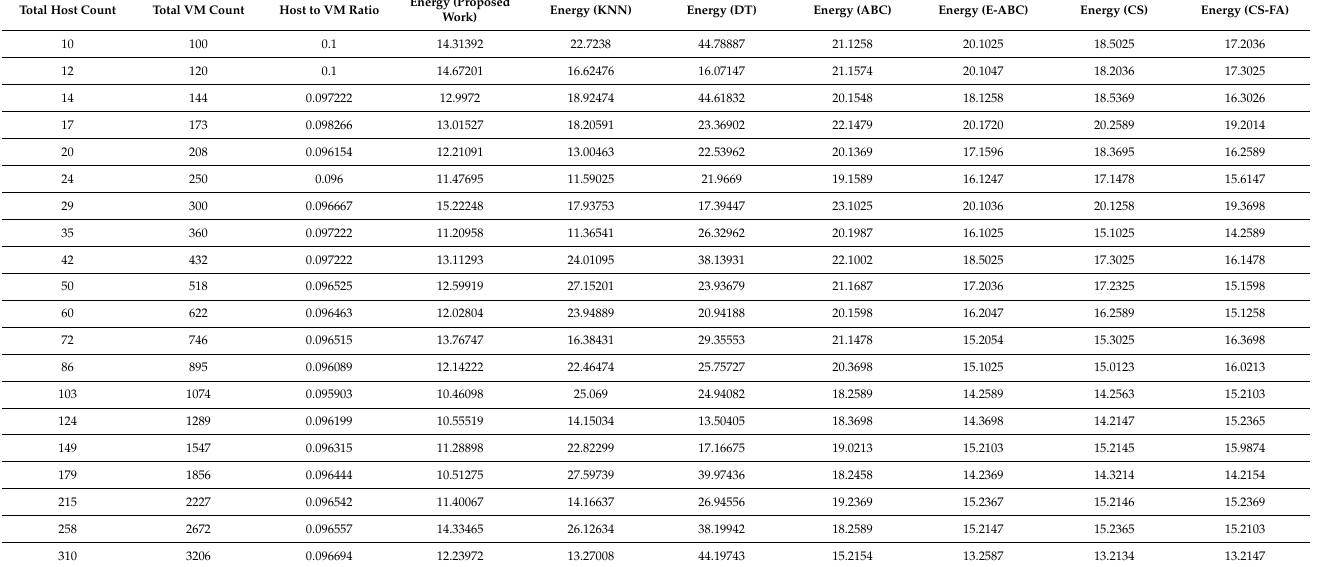
Table 4. Comparison in terms of energy consumption.